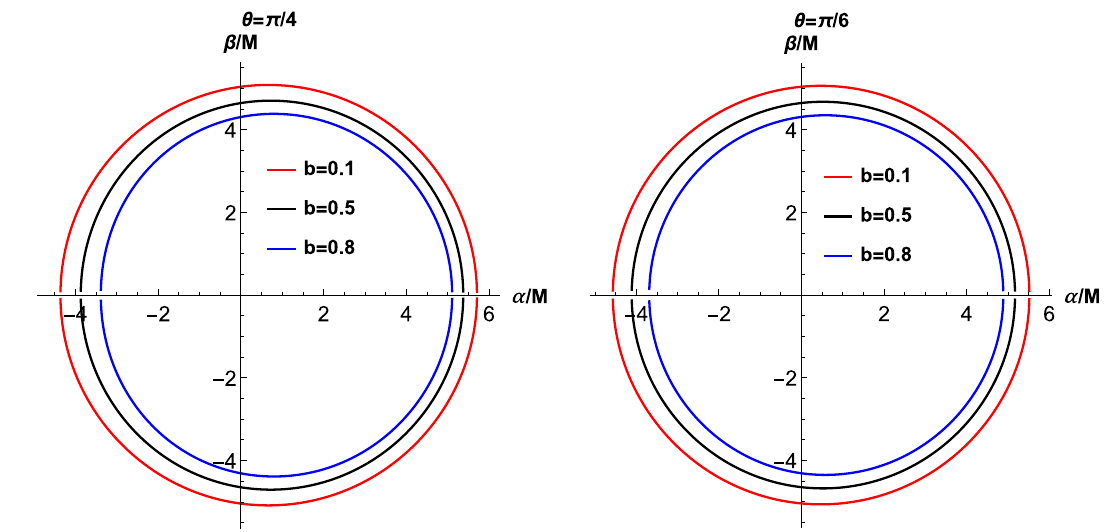
and θ = π with a = 0 . 4 , k = 0 . 2, and l = 0 . 2 2 3